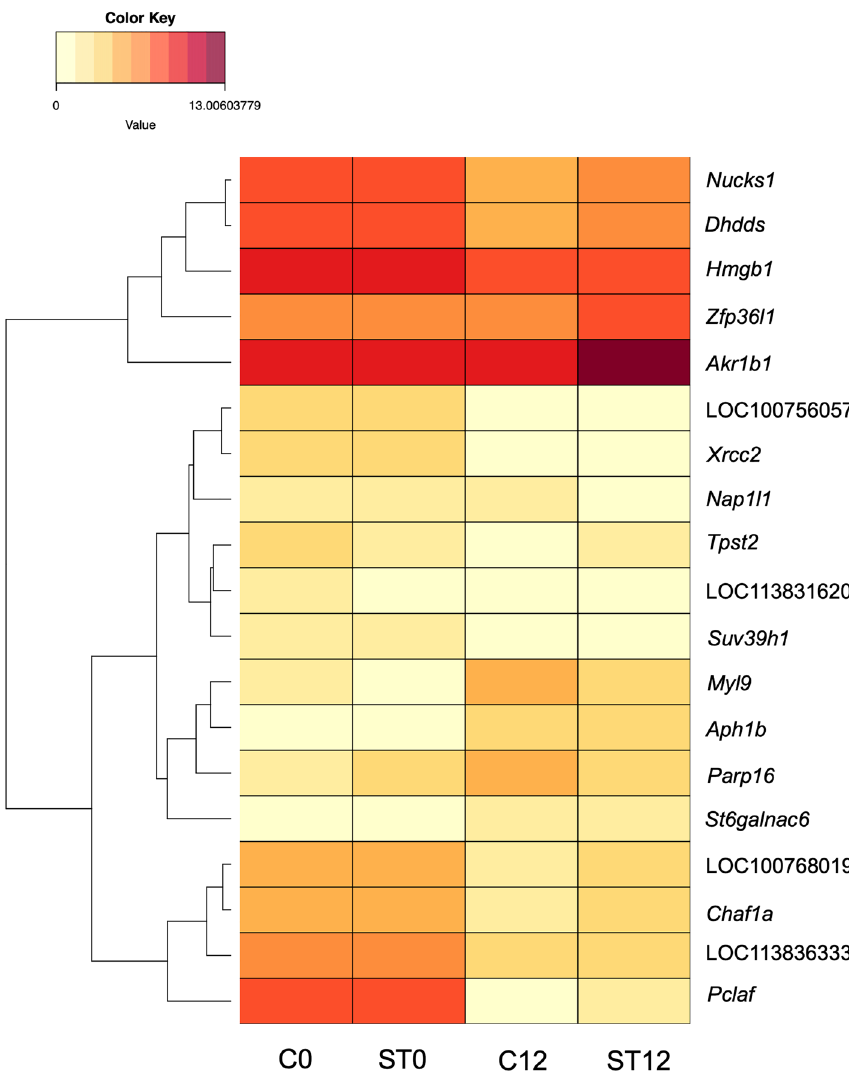
Figure 6. Heat map of differentially expressed genes from RNA-seq analysis that were only observed in one culture condition. Control is abbreviated as C and Lactate-stress is abbreviated as ST. Numbers in abbreviations are indicative of the Day samples were taken. Cells with light levels of shading indicate low levels of transcript abundance while darker cells correspond to higher levels of transcript